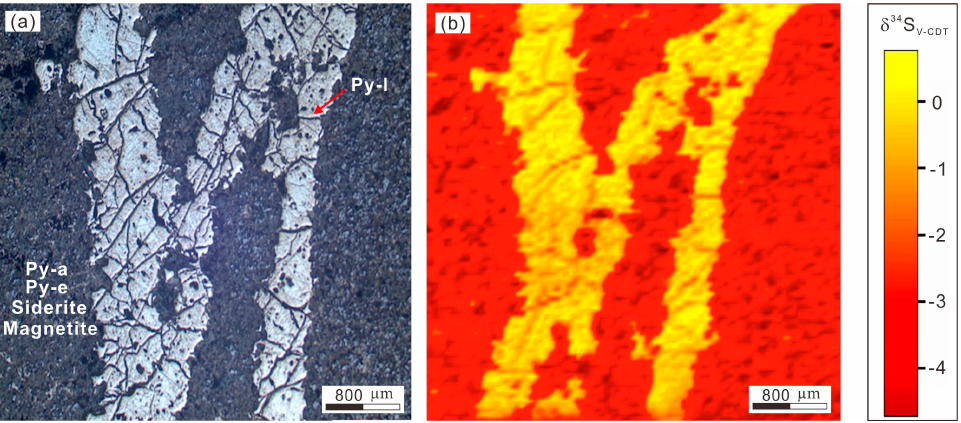
Figure 6. ( a ) Reflected-light image of mapped area and ( b ) LA-MC-ICP-MS S isotope map. The vein appearing bright on both the image and the map is Py-l, whereas the darker areas are the matrix dominated by siderite and magnetite but also containing interstitial Py-e and Py-a. Note that the S-isotope map shows that the S isotope signature of Py-l is about 4‰ heavier than Py-e and Py-a.